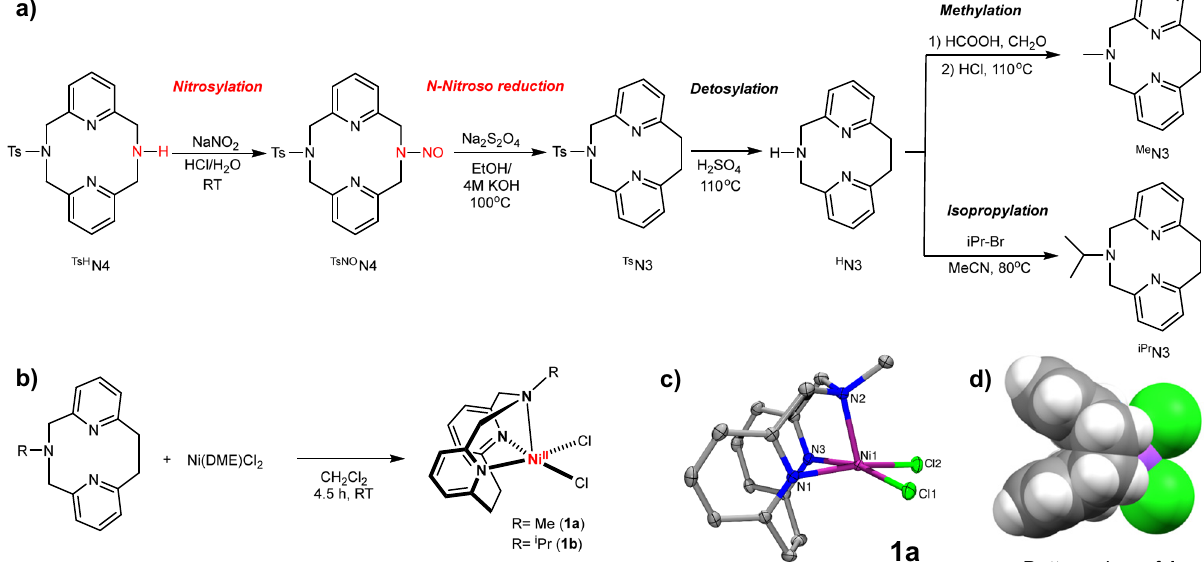
Fig. 2 Synthesis and structural characterization. a Synthesis of R N3 pyridinophane ligands. b Synthesis of ( R N3)NiCl 2 complexes (1a and 1b) and c ORTEP representation of the 1a obtained by X-ray diffraction (ellipsoids are shown at 50% probability and the hydrogen atoms omitted for clarity). Selected bond lengths (Å): Ni – N py 2.058, Ni – N amine 2.056, Ni – Cl 2.322. d Space- fi lling model of 1a highlighting the steric protection of the Ni center by the H atoms of the ethylene